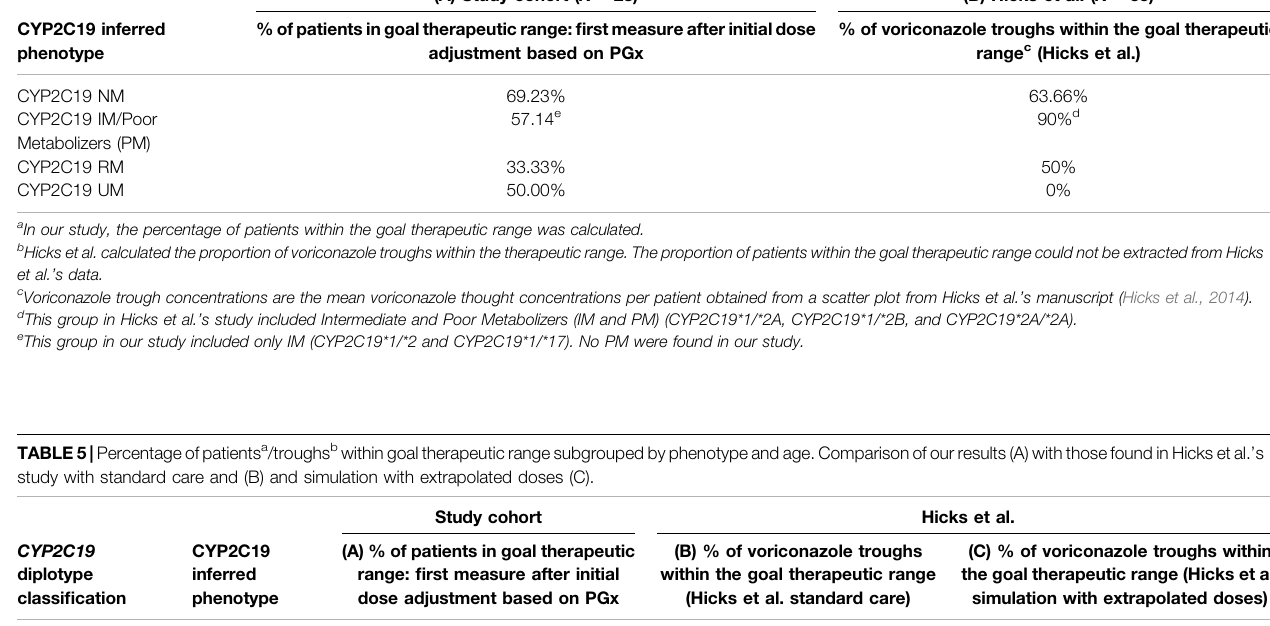
(A) % of patients in goal therapeutic range: fi rst measure after initial dose adjustment based on PGx